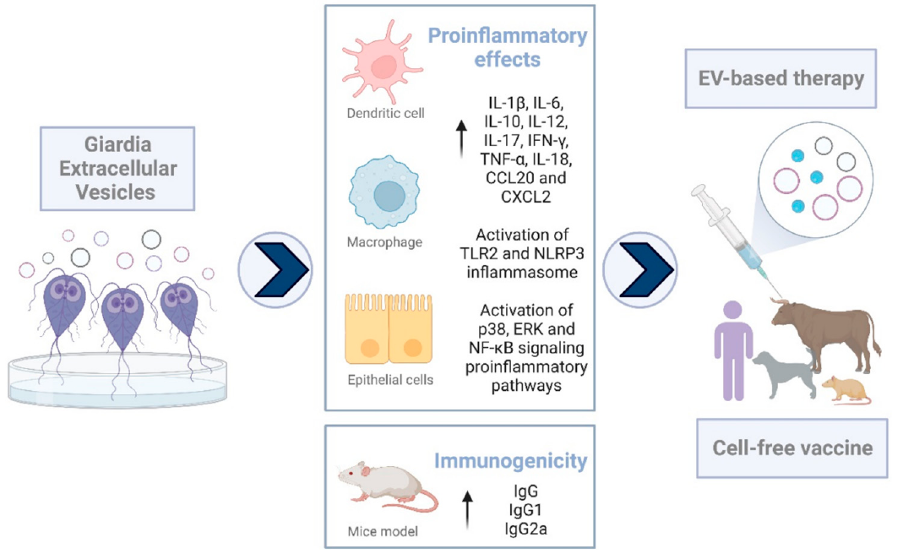
Figure 2. Effects of Giardia EVs in host cells (IL: interleukin; IFN-y: interferon-gamma; TNF- α : tumor necrosis factor α ; EV: extracellular vesicle; TLR2: toll-like receptor 2; NLRP3: NLR family pyrin domain containing 3; ERK: extracellular signal-regulated kinase; NF- κ B: nuclear factor kappa B) (created with BioRender.com).